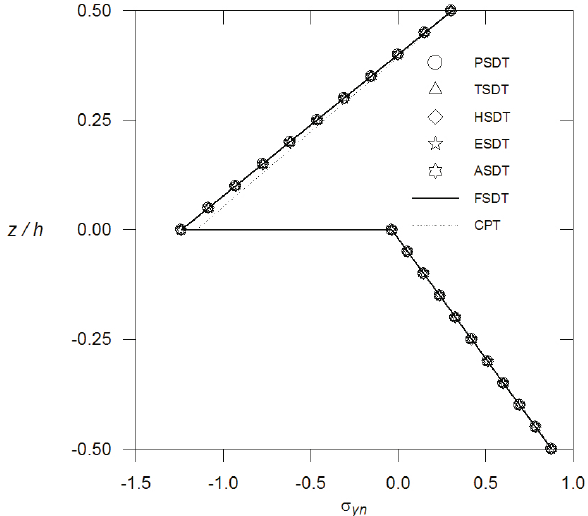
Figure 3: Variation of normalized in-plane normal stress σ y across the thickness for two layered (0 ∘ /90 ∘ ) anti-symmetric laminated composite square plate for aspect ratio ( b / h )